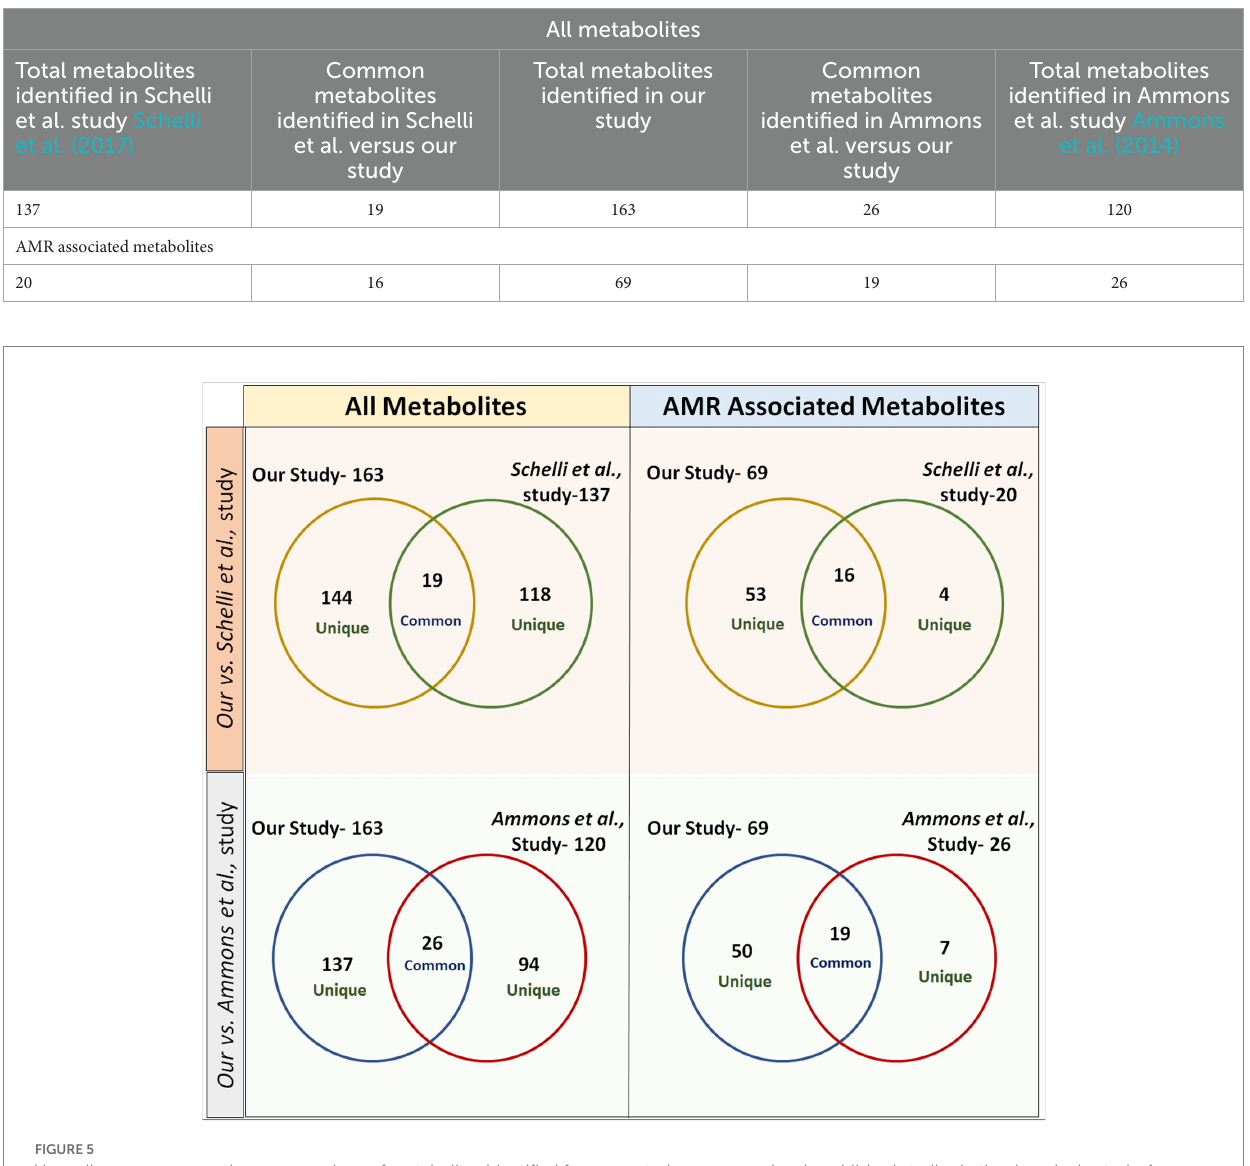
TABLE 4 Comparison of metabolites [total and antimicrobial resistance (AMR) associated] identified from our study versus other reported studies.